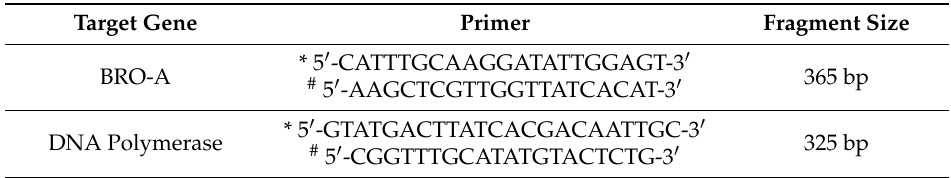
Table 1. Primers used for amplification of selected regions within the ORFs BRO-A and DNA